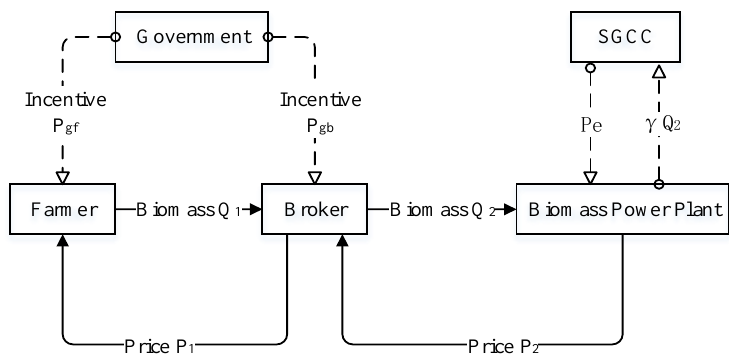
Figure 1. The structure of agribiomass power generation supply chain.